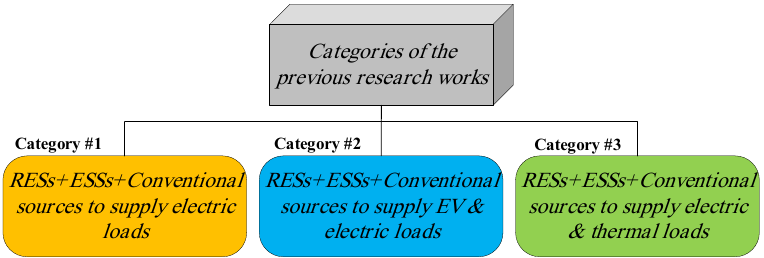
Figure 1. Different categories, according to the previous studies, in the fields of the optimal sizing and techno-economic assessment of hybrid energy systems. and techno-economic assessment of hybrid energy